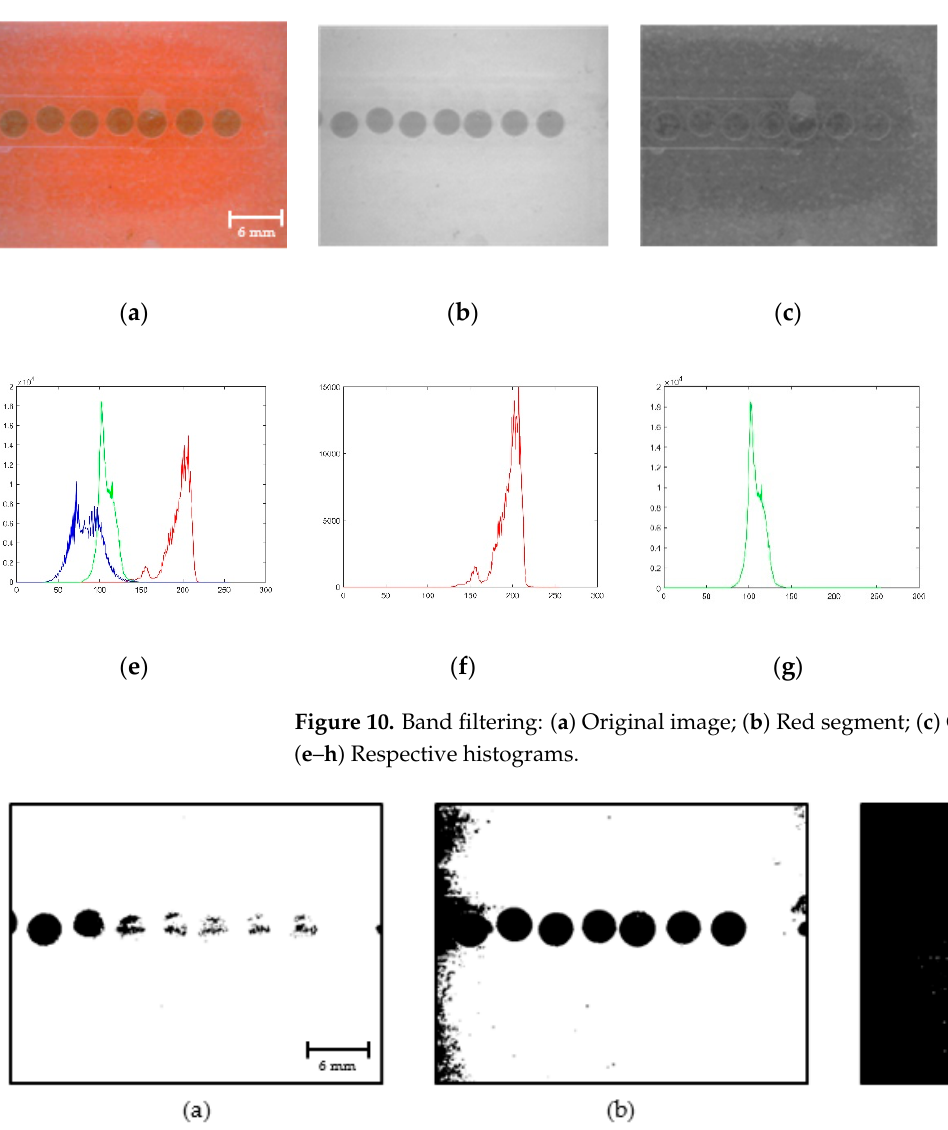
Figure 11. Comparison of threshold values: ( a ) 0.6; ( b ) 0.7; ( c ) 0.8.